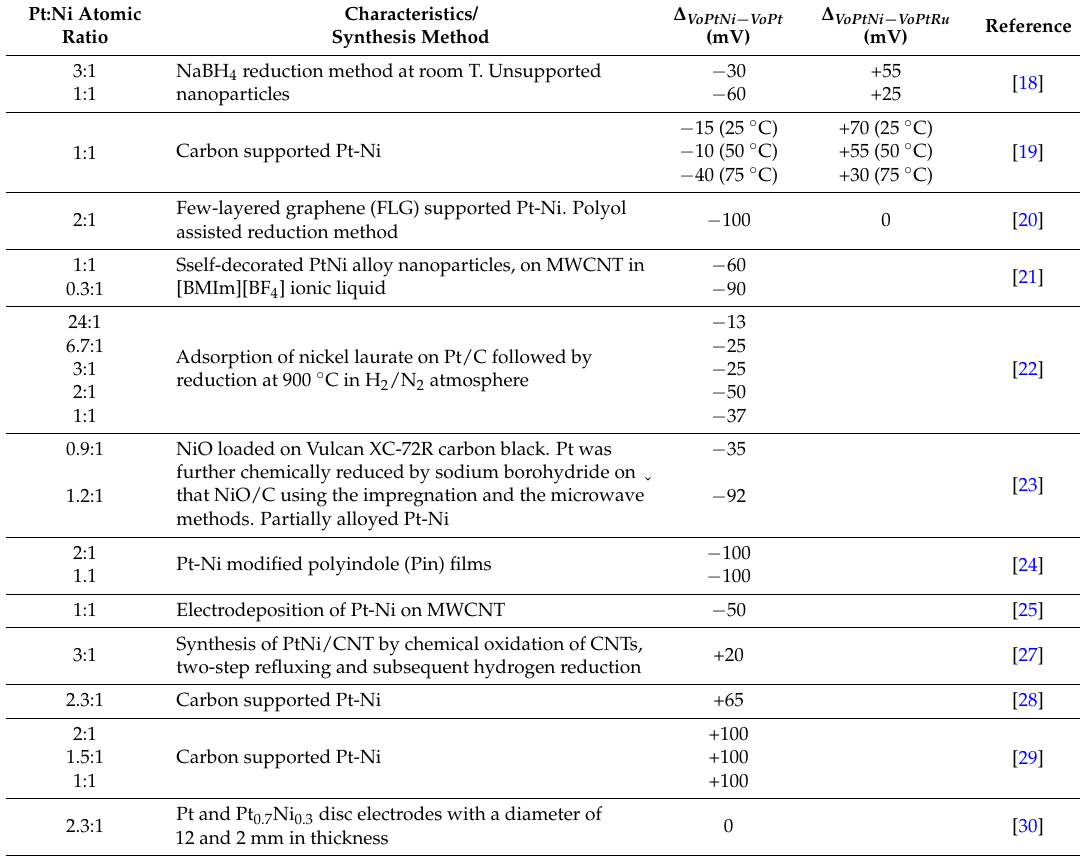
Table 1. Difference in MOR onset potential between Pt-Ni and Pt ( ∆ VoPtNi − VoPt ), and between Pt-Ni and Pt-Ru ( ∆ VoPtNi − VoPtRu ) for some Pt-Ni catalysts with various Pt:Ni atomic ratio and prepared by different synthesis